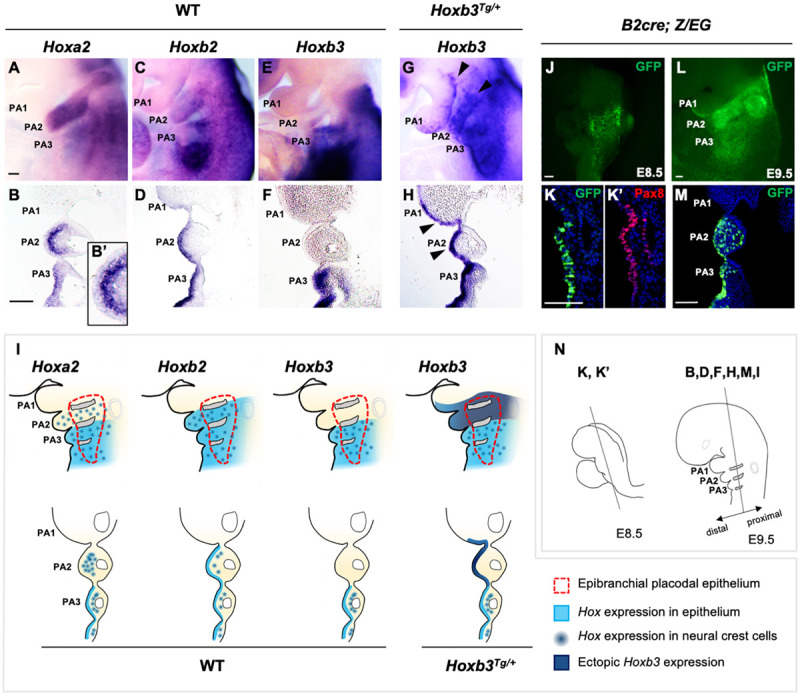
Expression of Hox genes in pharyngeal arches of wildtype and Hoxb3Tg/+ embryos. (A–H) Wholemount in situ hybridization and coronal sections showing expression of Hoxa2, Hoxb2, and Hoxb3 in wildtype and mutant E9.5 embryos (n = 3). An enlarged image in (B’) showing the absence of Hoxa2 expression in the epithelium covering PA2. Arrowheads in (G,H) indicate ectopic expression of Hoxb3 in the pharyngeal epithelium of PA1 and PA2. (I) Schematic summary of Hox gene expression in the pharyngeal ectoderm, epibranchial placodal region, and neural crest cells of E9.5 wildtype and Hoxb3Tg/+ embryos. (J,K) Wholemount GFP autofluorescence (J) and co-immunostaining of GFP (K) and Pax8 (K’) in coronal section of E8.5 B2-Cre;Z/EG embryos (n = 3). (L,M) Wholemount GFP autofluorescence (L) and immunostaining of GFP in coronal section (M) of E9.5 B2-Cre; Z/EG embryos (n = 3). (N) Schematic diagram illustrating the plane of embryo sections for the indicated panels in this figure. PA1, PA2, and PA3 indicate the 1st, 2nd, and 3rd pharyngeal arches. Scale bars: 100 μm.